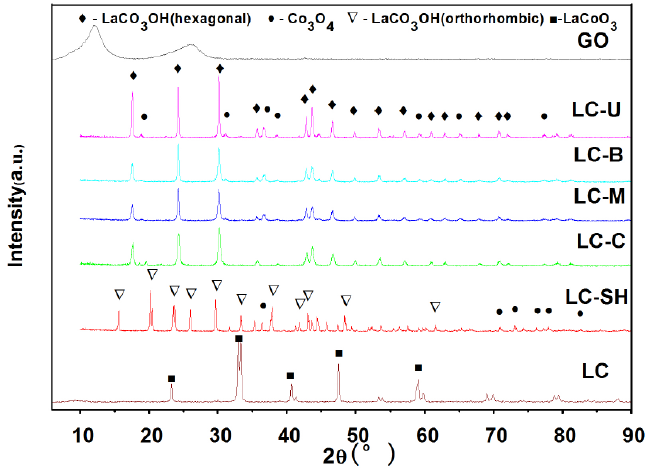
Figure 3. X-ray diffractometer (XRD) pattern of catalysts with different nitrogen sources.